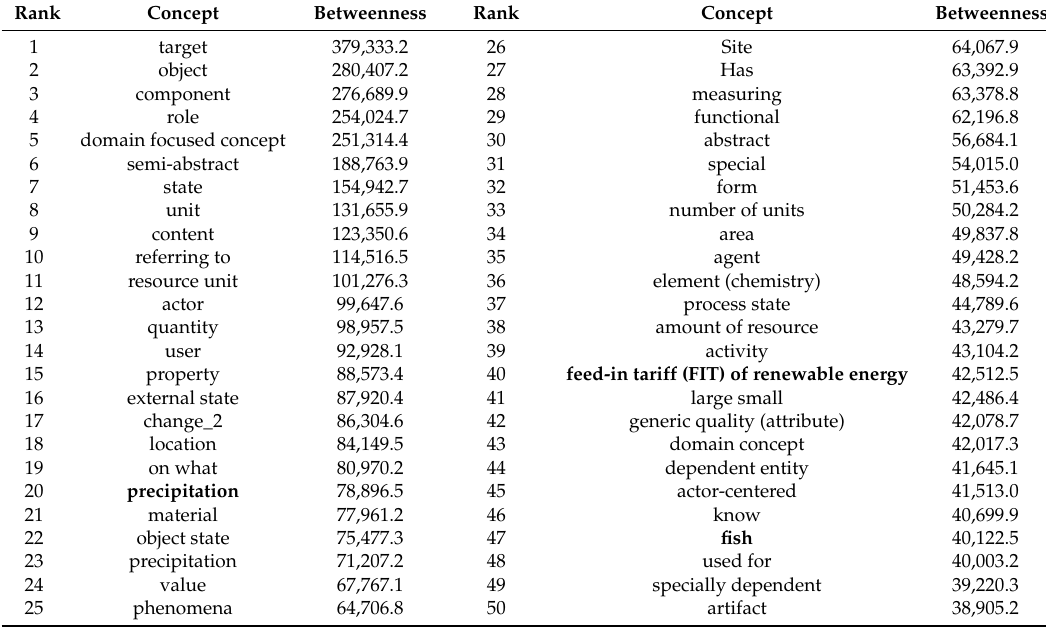
Table 2. Top 50 betweenness centrality index in the water–energy–food (WEF) nexus domain ontology.